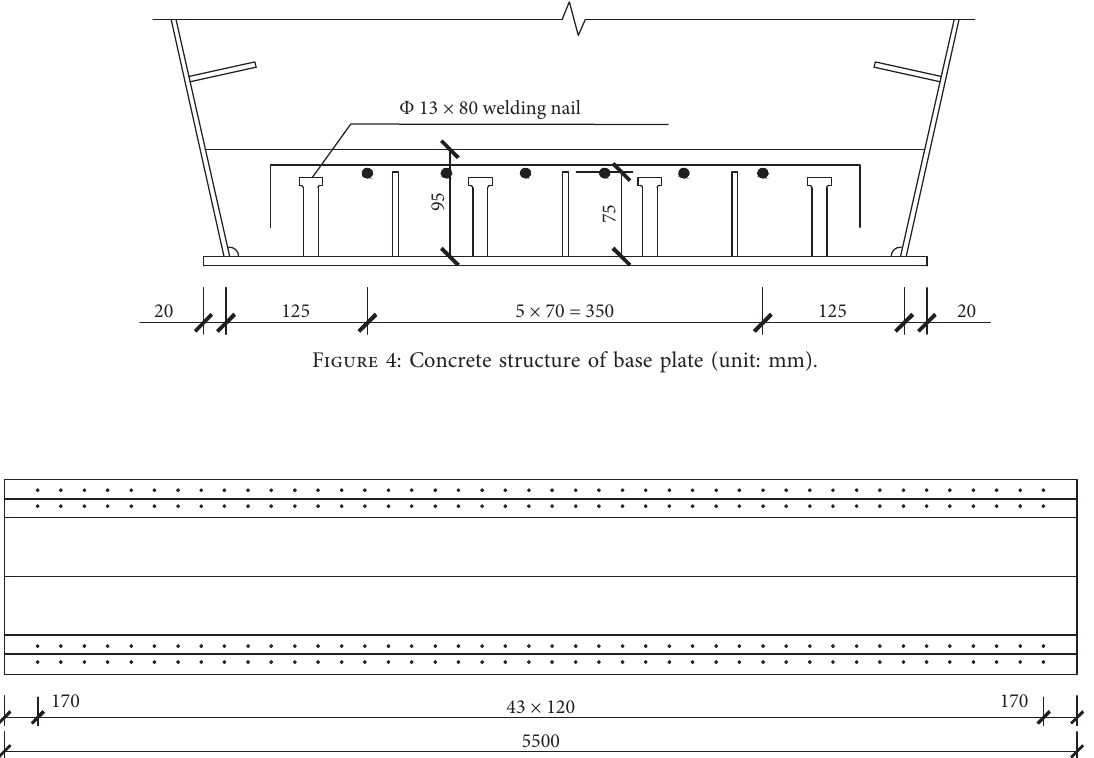
Figure 5: Layout of welding nails on the upper flange (unit: mm).